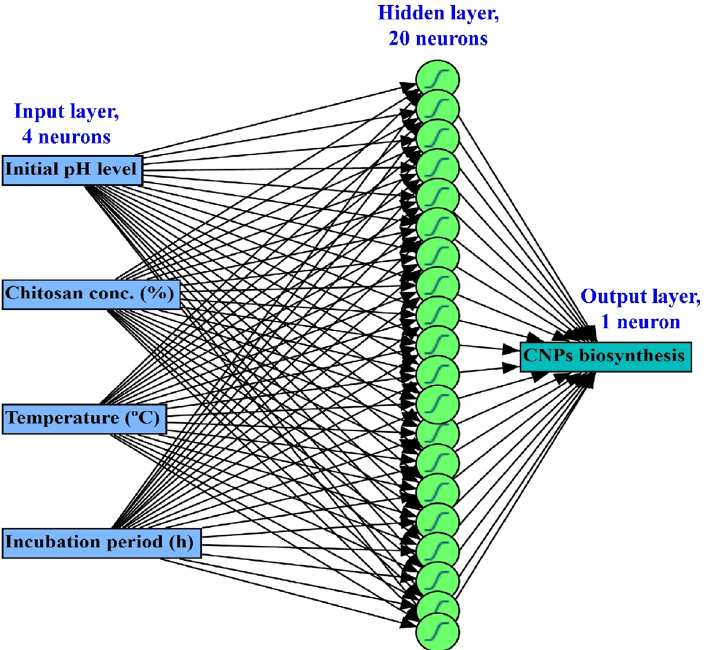
Figure 12. The final artificial neural network of CNPs biosynthesis by Streptomyces microflavus strain NEAE- 83. The architecture scheme shows an input layer (4 neurons), a hidden layer (20 neurons), and an output layer with a single